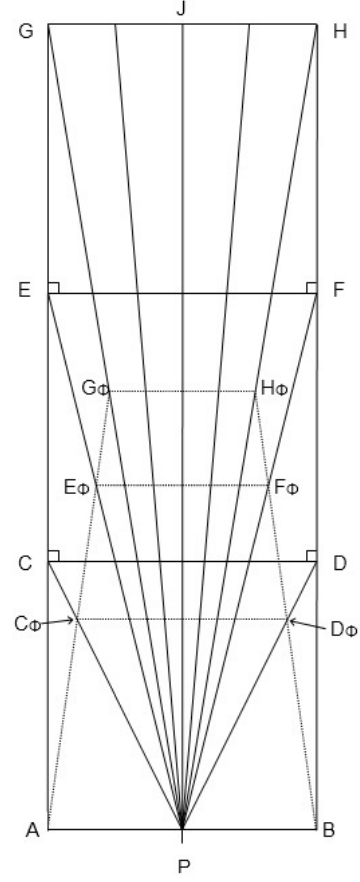
Figure 1. Diagram illustrating the spatial contraction proposed in Hatfield’s Perspective-Based model.